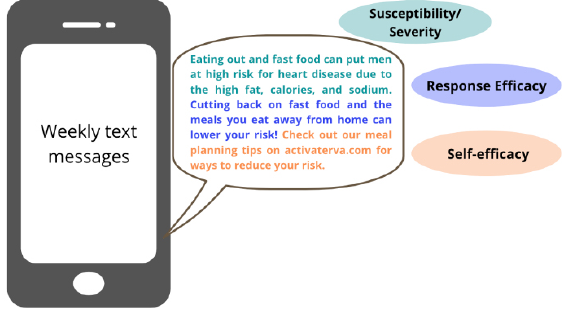
Fig. 2. Example of weekly text message based in extended par- allel process